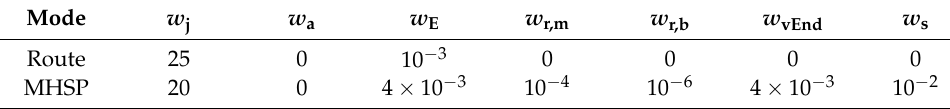
Table A1. Weighting Factors.